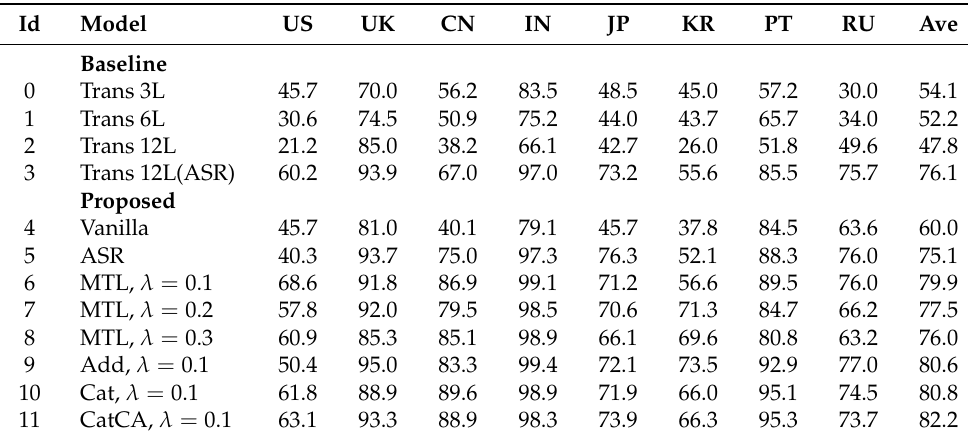
Table 2. The baseline systems use the encoder of Transformer and a statical pooling to perform the AR task. In Table 2, they are denoted as Transformer- X L, where X represents the number of the encoder layers. Table 2. Accuracy comparison. The vanilla versions (Id 0–2, 4) are demonstrated in Figure 3a.